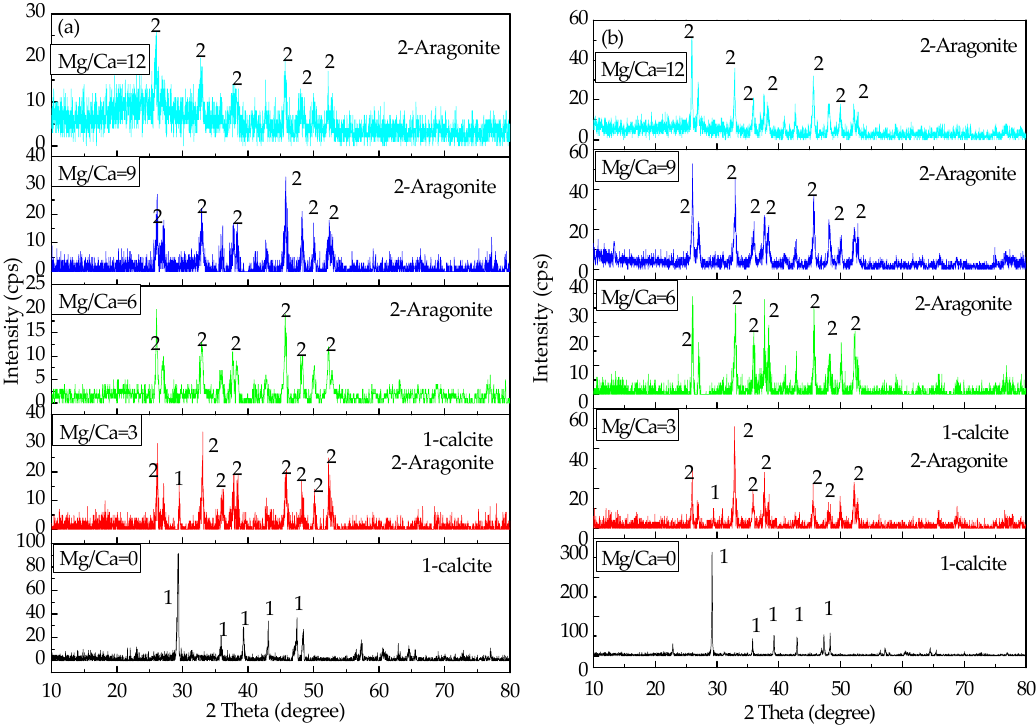
Figure 4. X-ray diffraction (XRD) analyses of the minerals cultured for 14 days ( a ) and 24 days ( b ).